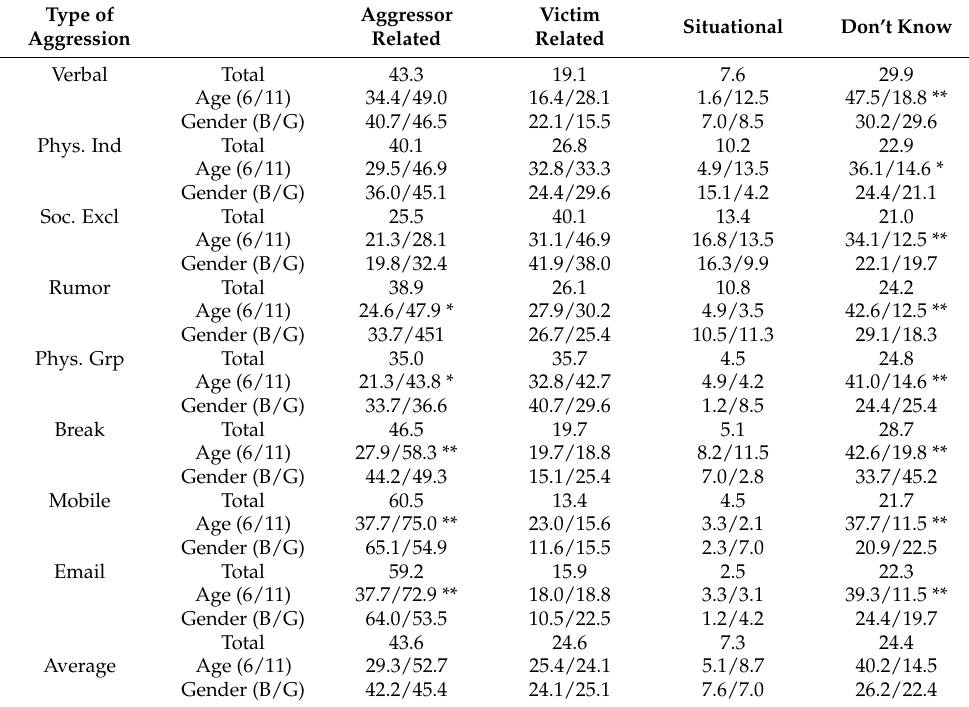
Table 6. Percentages of children giving each category of causal attribution, by type of aggression, age, and gender. Type of Aggression